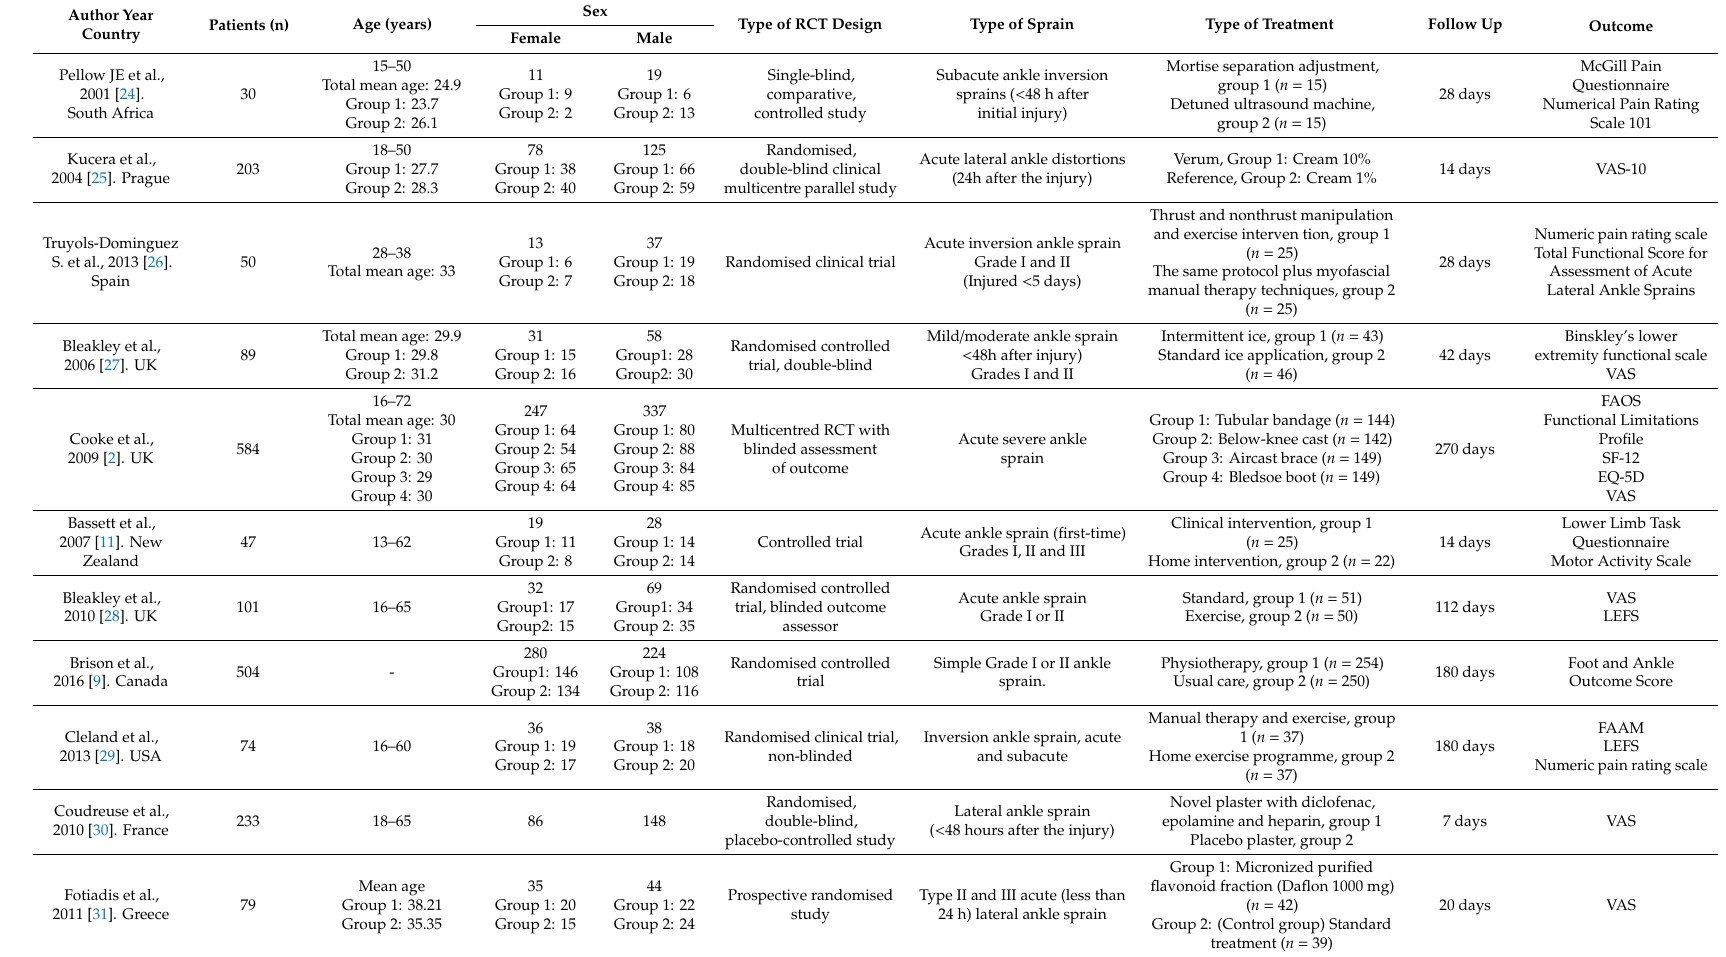
Table 1. Characteristics of the studies included in the